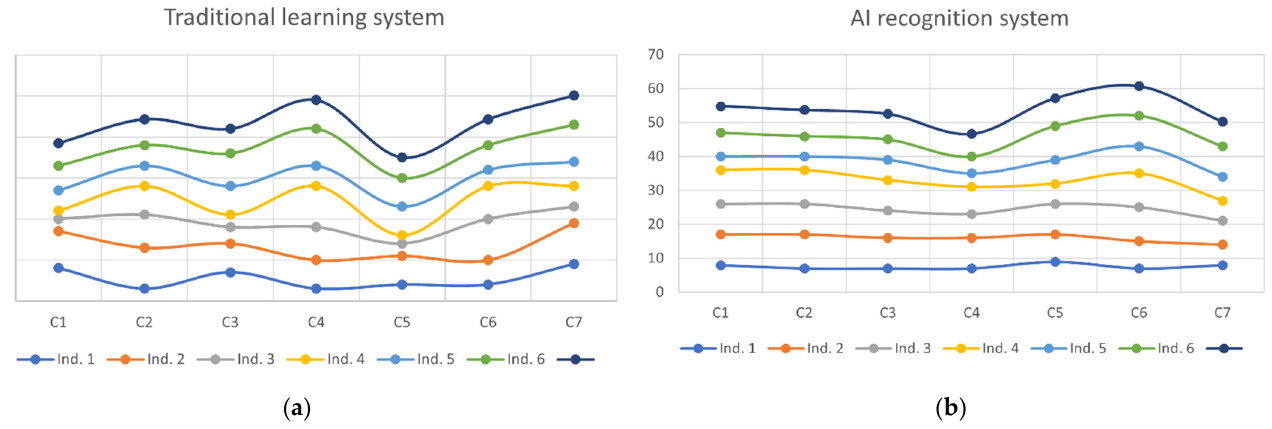
Figure 4. Comparison between a traditional education model and a model that uses an AI recognition system: ( a ) traditional number teaching model; ( b ) teaching numbers with a recognition system with the use of AI.